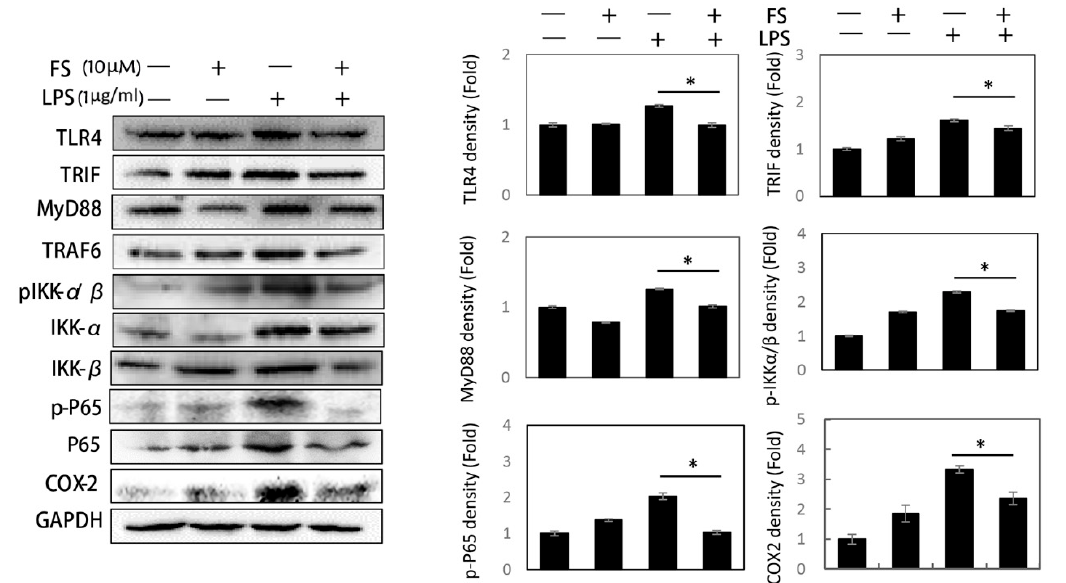
Figure 3. Inhibition of FS on the TLR4 / NF-kB pathway. The expressions of proteins on TLR4 / NF- κ B pathway were detected by Western blotting. The main protein levels in the results of Western blotting were measured by Image J software and shown in the diagram. * p -value < 0.05.